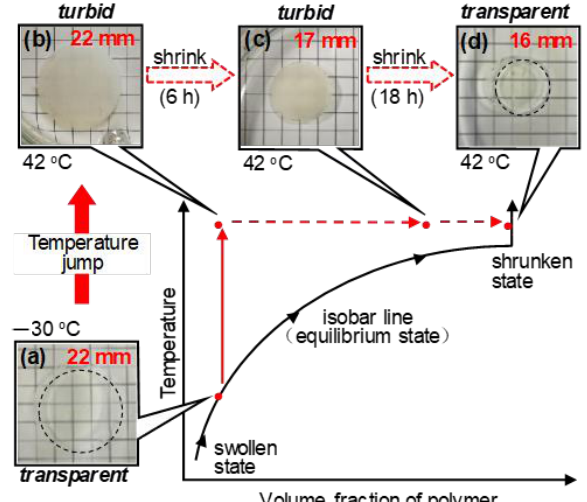
Figure 3. Photographs of P1a-gel ( a ) sufficiently swollen at − 30 ◦ C and ( b – d ) during the isothermal deswelling process at 42 ◦ C: ( b ) immediately after changing to 42 ◦ C, ( c ) after 6 h, and ( d ) after 18 h. The inserted value in the photographs denotes the diameter of the P1a-gel . Dashed circles were drawn as visual guides for the outer shape of the gels. Each square of the grid corresponds to 5 mm. The schematic phase diagram (Temperature vs. Volume fraction of polymer) was reported for the thermoresponsive hydrogels by Shibayama et al.